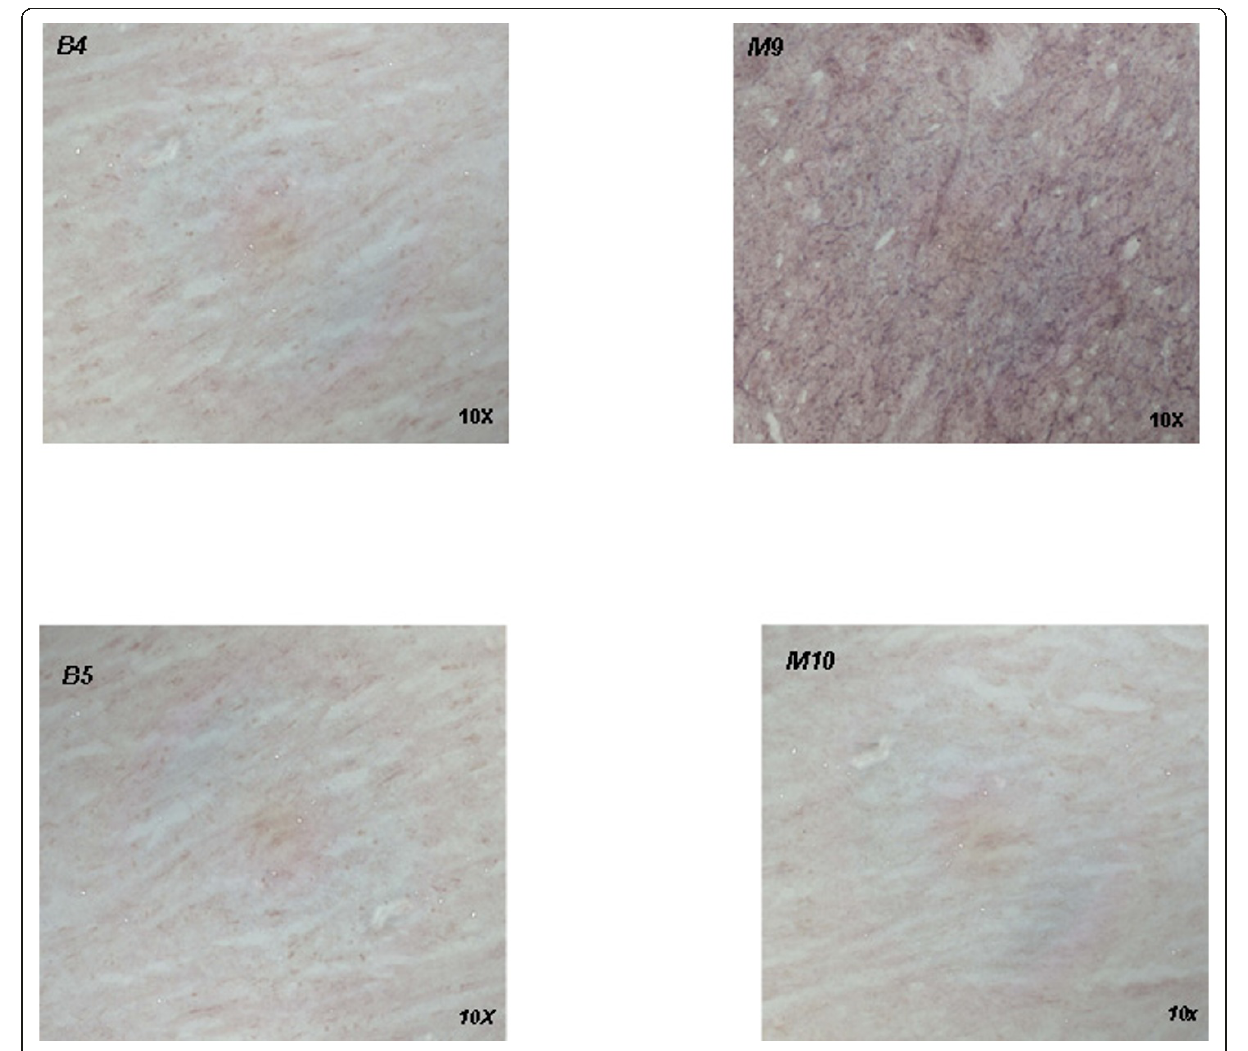
Figure 3 Non-radioactive in-situ RNA hybridization on cryosections obtained from the left ventricle of an explanted human heart . Isoform-specific RNA probes recognized the 5 ’ UTR region and first exon of B and M isoforms. The M antisense probe ( M9 top right ) displayed an intense signal of hybridization whereas the B antisense probe failed to hybridize ( B4 top left ). Both the M ( M10 bottom right ) and B sense ( B5 bottom left ) probes failed to